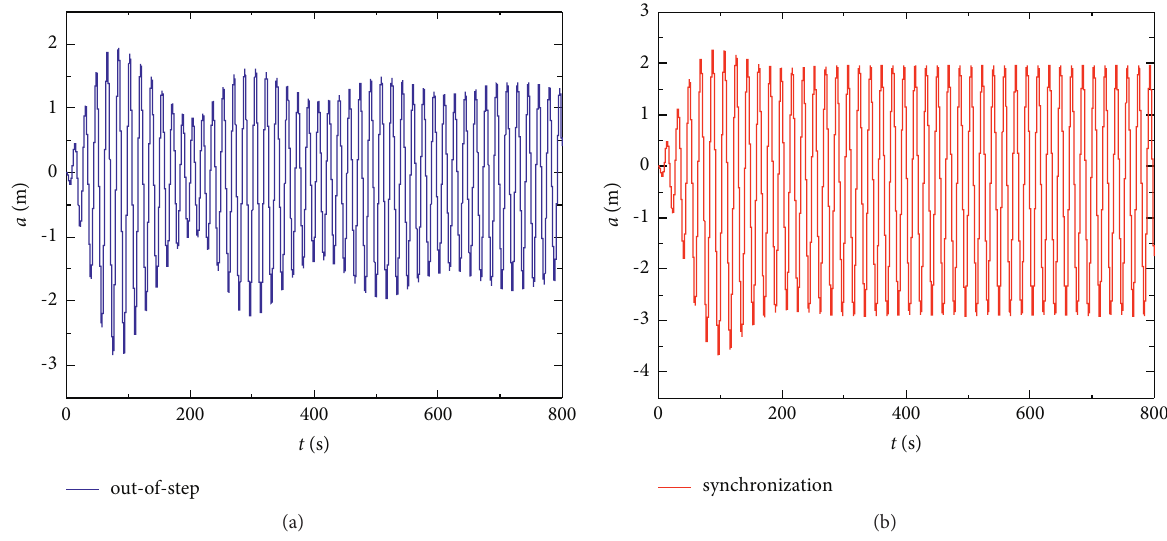
Figure 22: The displacement time history curve of primary resonance. (a) Synchronization ( σ � − 0.01). (b) Out-of-step ( σ �